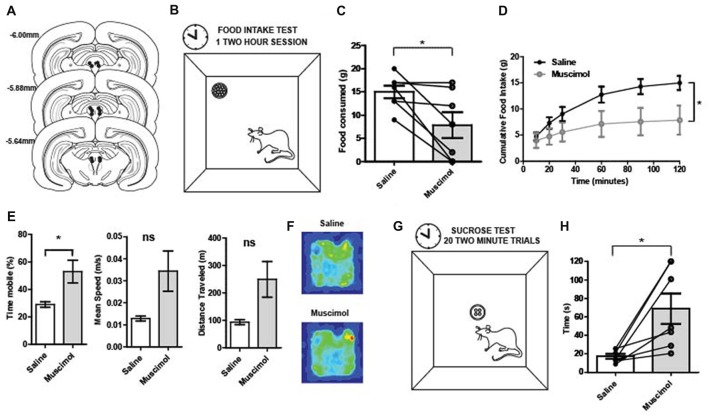
(A) Reconstruction of bilateral cannulae tip placement (N = 7) that targeted the periaqueductal gray (PAG). (B)
Food intake test: during the 2-h test, rats were placed in the arena (40 × 40 × 40 cm). A food cup was filled with 1 g chow pellets. Food was weighed at 20, 30, 60, 90 and 120 min. (C)
Food in take test results: following temporary inactivation of the PAG, the total amount of food consumed over 2 h was significantly decreased compared to vehicle treated rats (t(6) = 2.95, p = 0.01). (D) PAG inactivation produced changes in cumulative food intake over time. There was a main effect of time (two-way repeated measures ANOVA, F(5,30) = 21.23, p < 0.01), no main effect of treatment group (F(1,6) = 4.37, p = 0.08), but a significant interaction between time and treatment group (F(5,30) = 22.24, p < 0.01). The two treatment groups were significantly different (p < 0.05) towards the end of the testing period, at the 90 and 120-min time points. (E) Movement data collected during the 2-h food intake test revealed that reduced consumption was not due to less activity. Muscimol-treated rats showed increased locomotion relative to saline on measures in terms of total time mobile (t(6) = 2.71, p = 0.04). (F) Average occupancy data over the 2 h food intake test for each group of rats. The total time in various arena locations were similar between saline- and muscimol-treated rats. (G)
Latency to consume sucrose test: four 45 mg sugar pellets were placed in the food cup. The latency to consume all four sugar pellets was recorded. Rats were given 120 s to consume the four pellets before they were taken away and the inter-trial interval (ITI) began. A session consisted of 20 trials. (H) Latency to consume sucrose after PAG inactivation: Individual points represent rats’ mean latency to consume sucrose pellets over 20 trials. The time it took muscimol-treated rats to consume four 45 mg sugar pellets was significantly increased relative to vehicle treated trials (t(6) = 3.37, p = 0.01). All error bars represent ±SEM. *p ≤ 0.05; ns, not significant.